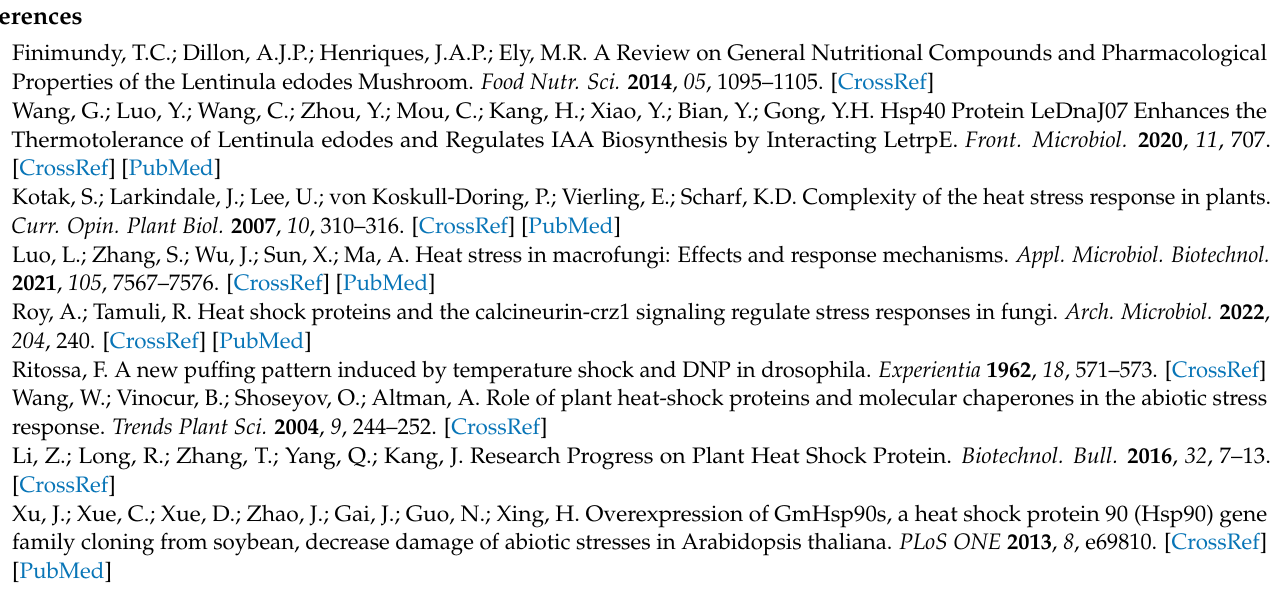
Table S2. Information of Domains in HSPs. Table S3. Amino sequence of motifs in